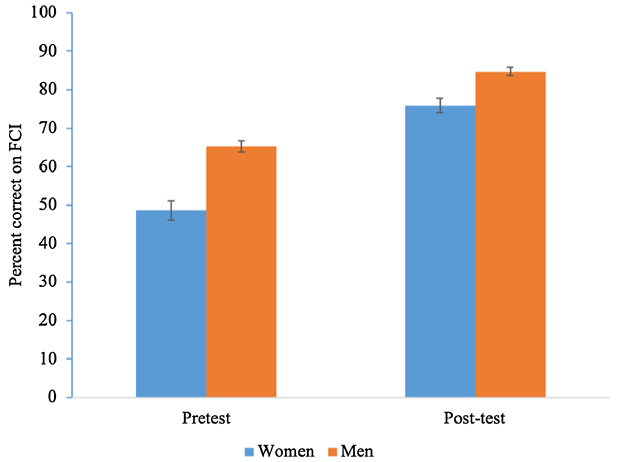
FIG. 1. Force Concept Inventory prescores and postscores (%) for men and women. Error bars represent the standard error of the